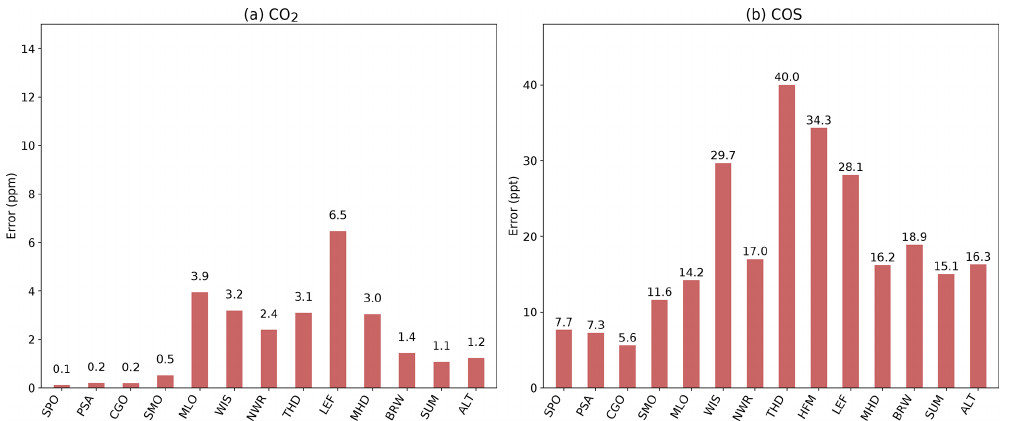
Figure 4. Assigned error standard deviations for each station and for (a) CO 2 and (b) COS. Stations are ordered from the South Pole (on the left) to the North Pole (on the